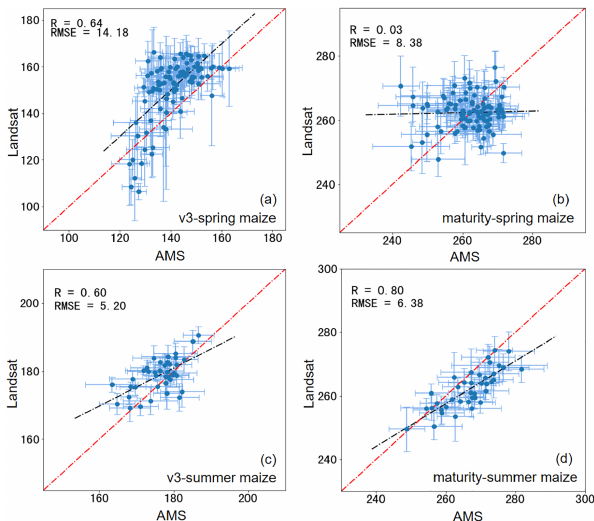
Figure 7. Comparison of long-term mean phenological indicators derived from Landsat (satellites) and AMS (in situ). The error bars of the x - and y -axes represent uncertainty (i.e., one standard de- viation) of multi-year phenological indicators and the mean pheno- logical indicators within a certain extent (5km) of the AMS, respec- tively. (a) – (b) and (c) – (d) represent results from spring and summer maize, respectively.